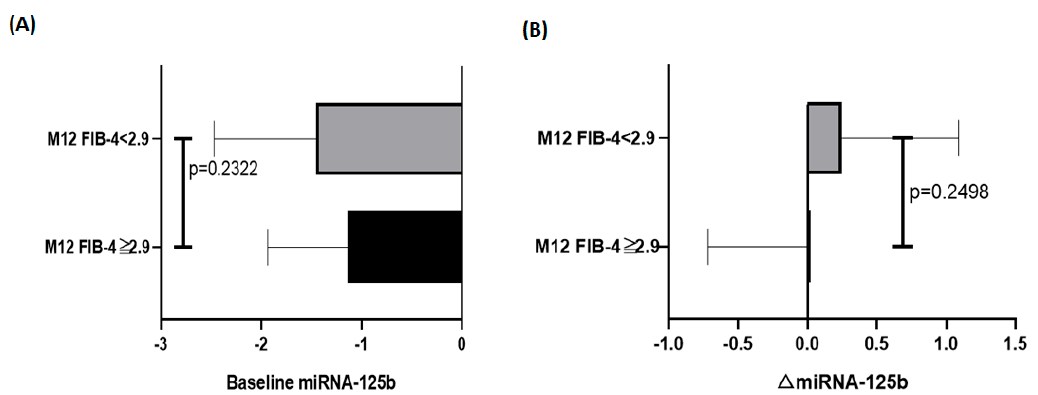
Figure 3. Comparing two subgroups divided by a post-treatment FIB − 4 index of 2.9, showing the differences in the ( A ) baseline miRNA − 125b (log 2^baseline miR − 125b) and ( B ) △ miRNA − 125b (log 2 − delta post − miR − 125b − log 2 − delta pre − miR − 125b ). Error bars show mean ± standard deviation. p value from the Mann–Whitney test is shown.